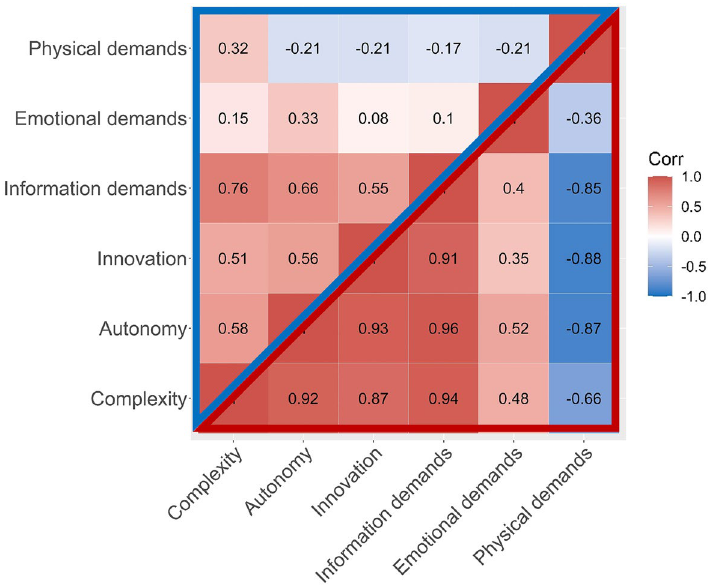
Figure 1. Pairwise phenotypic and genetic correlations among six job attainment characteristics in UK Biobank data. The upper-left triangular correlation matrix is the pairwise phenotypic correlation and the lower-right is the genetic correlation matrix. Phenotypic correlation, Pearson correlation coefficient, was calculated based on the UK biobank participants included in this study (n = 219,483). Genetic correlation was calculated based on the GWAS summary statistics using LDSC method from the same set of participants. The correlation coefficient is shown in each sub-box. Positive correlation is displayed in red and negative correlation in